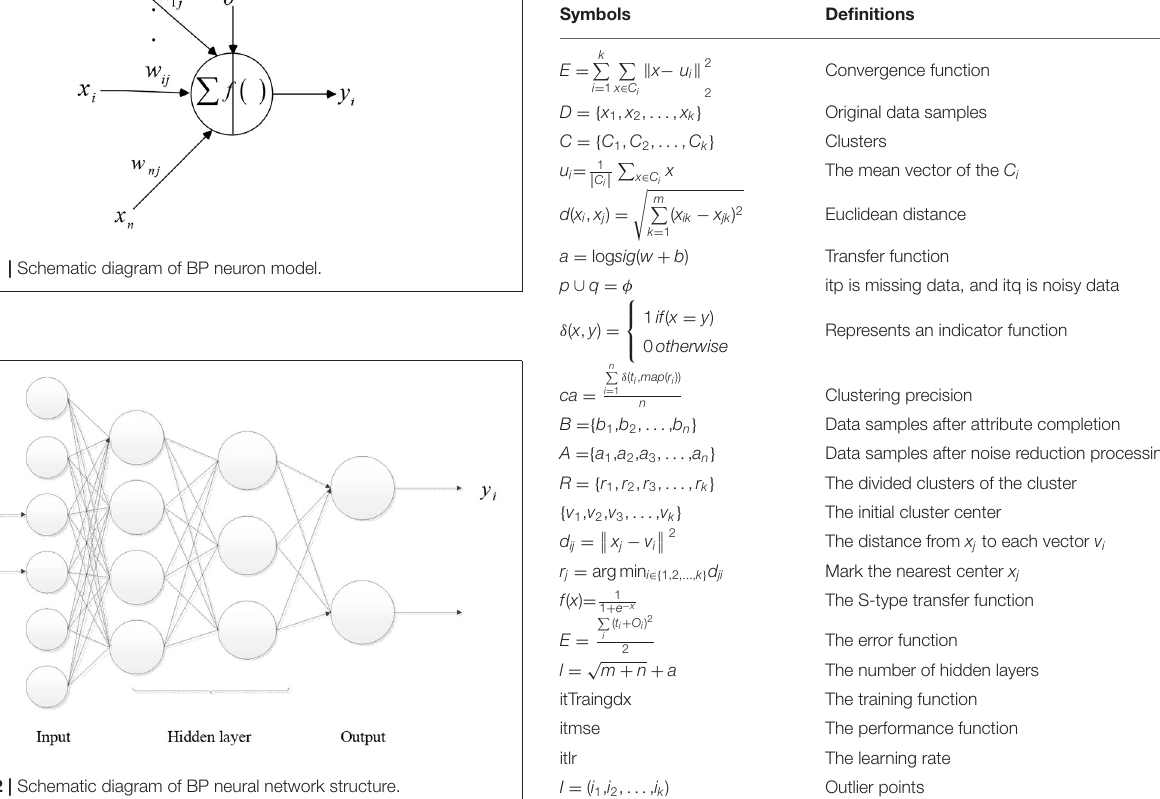
TABLE 1 | The main